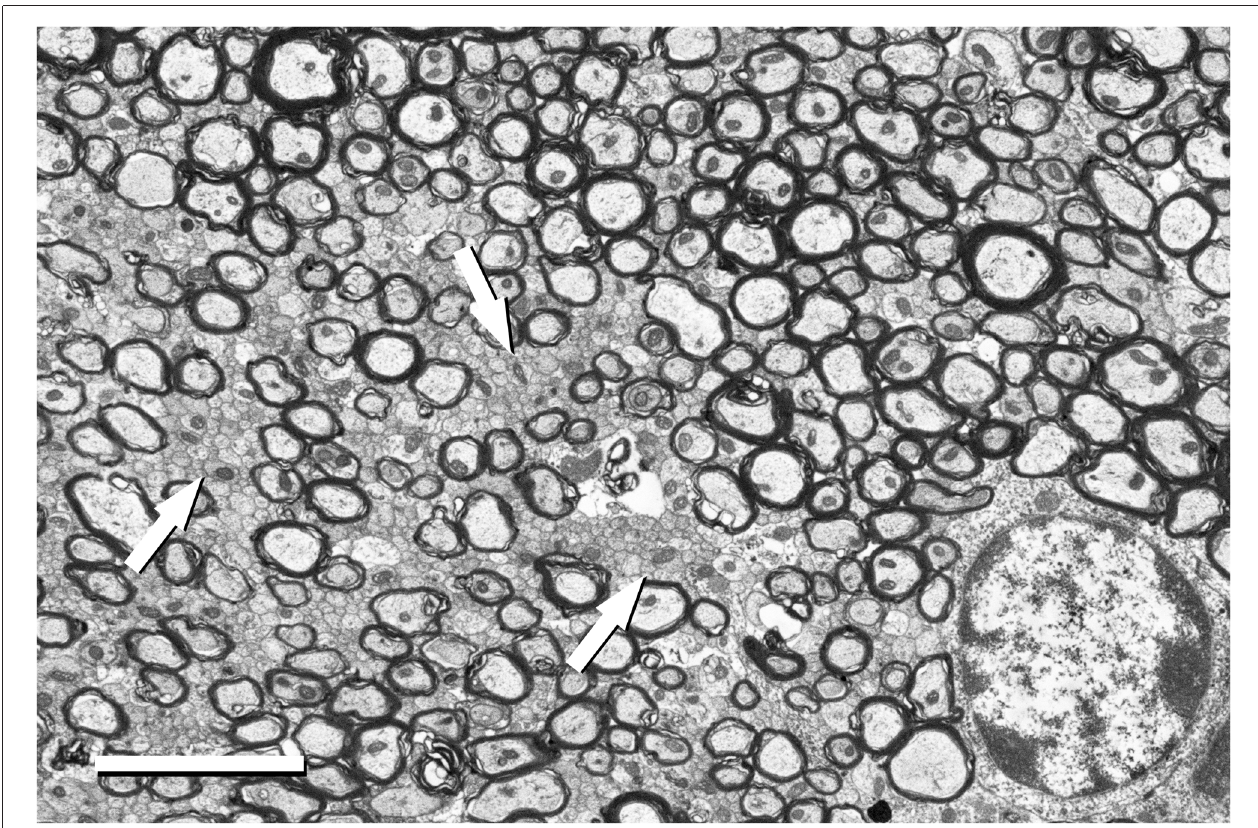
FIGURE 5 | Detail of the fimbria hippocampi of the mouse. This image was acquired from the small boxed area of Figure 4A with the BSE detector at 5050 × (resolution of 11.05 nm/pixel), with an acceleration voltage of 2.00 kV. Bundles of unmyelinated fibers (arrows) which are intermingled between myelinated fibers can be seen. The cell body of an oligodendrocyte is visible in the bottom right corner. Calibration bar: 4 µ m.